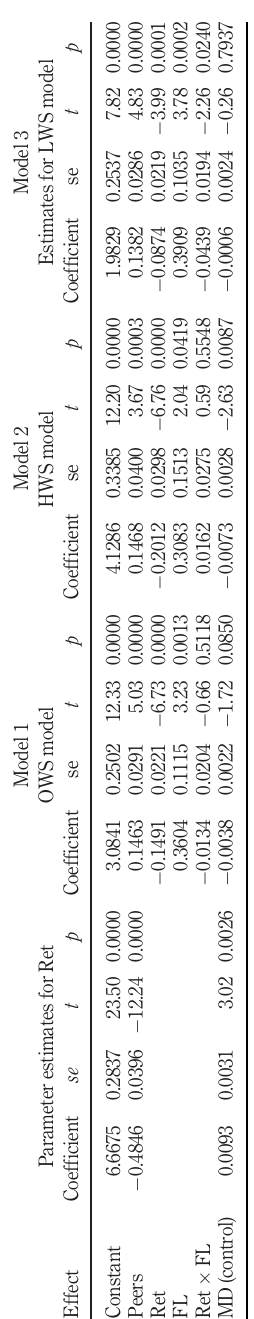
Table 3. Estimated